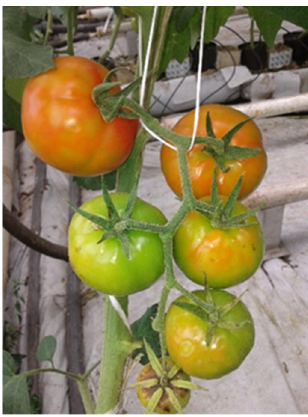
Figure 1. Tomato fruits grown in commercial greenhouse infected with TYRV.